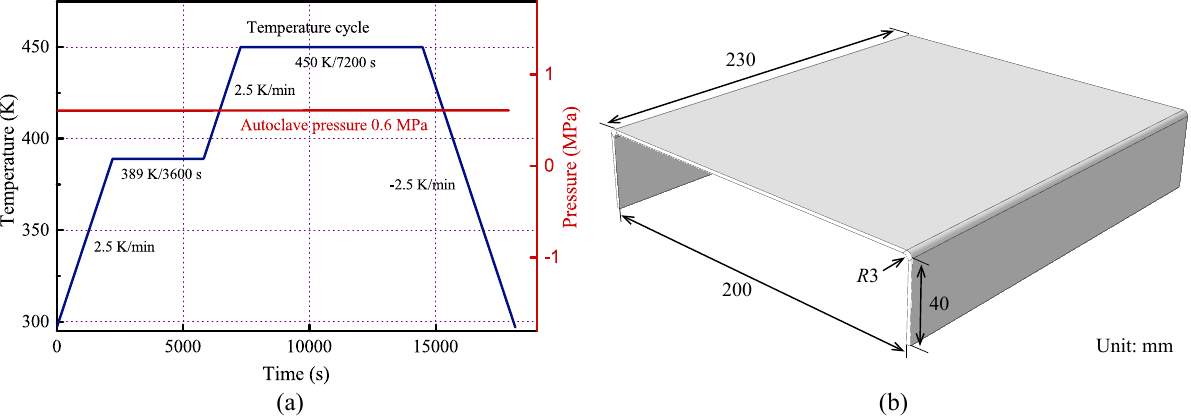
Figure 1. Experimental design of the C-shaped composite specimen: ( a ) Curing profile; ( b ) Geometric size.